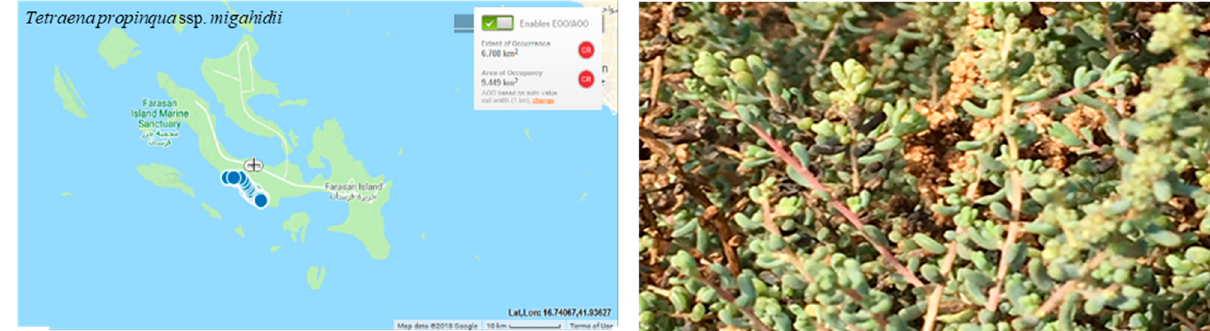
Figure 8. Geographical distribution of Tetraena propinqua ssp. migahidii in the Farasan Archipelago (plant photo by R. Al-Qthanin from Faranan Alkabir